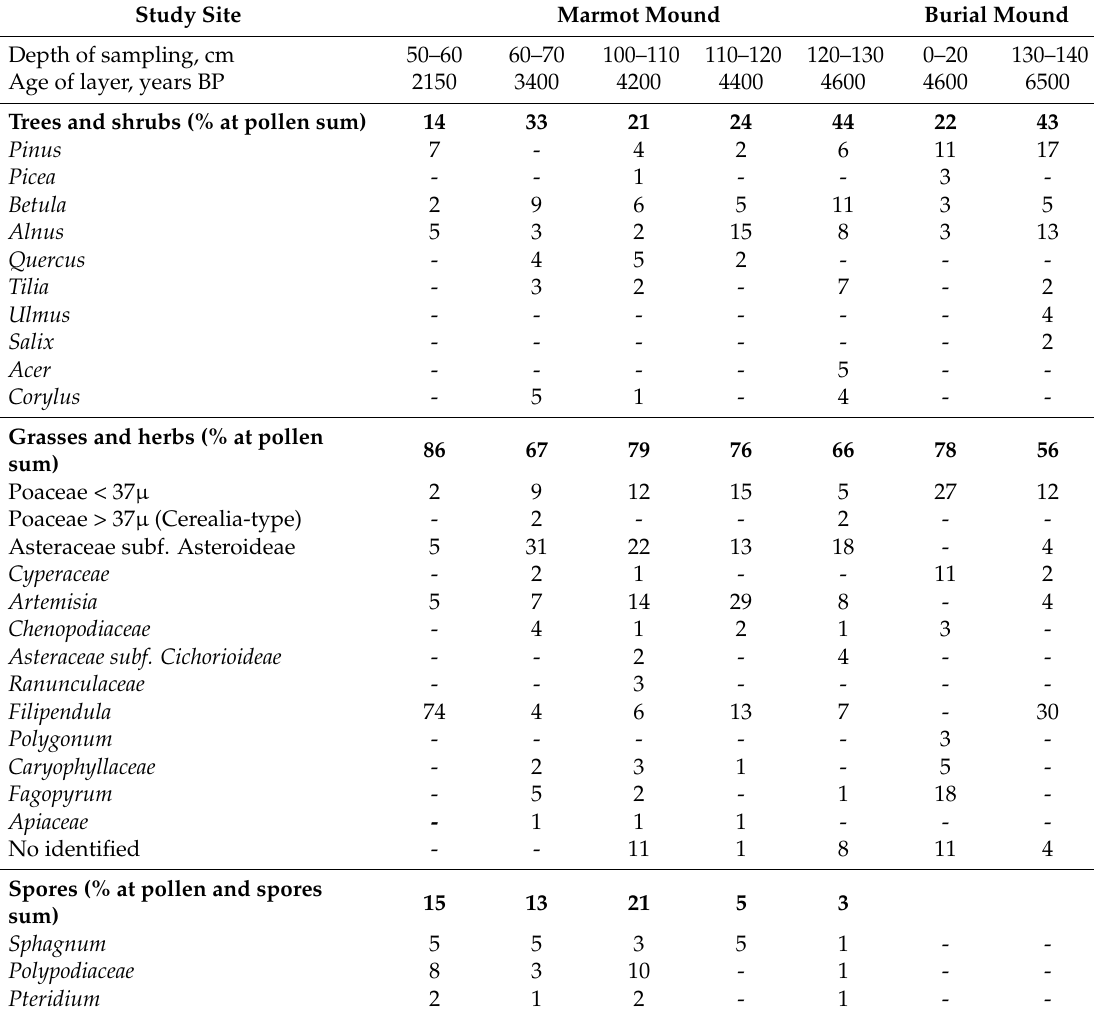
Table 4. Pollen spectra of soils buried under the marmot mound and under the burial mound of the Bronze Age in the Yamskaya